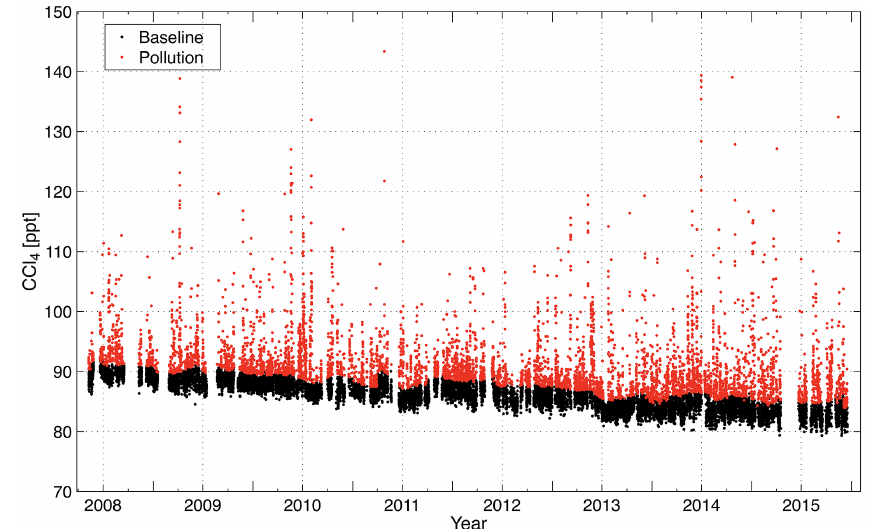
Figure 1. Atmospheric CCl 4 concentrations observed from 2008 to 2015 at Gosan station (GSN, 33 ◦ N, 126 ◦ E) on Jeju Island, Korea. Pollution events (identified as significant enhancements in concentrations from background levels shown in black) are denoted by red